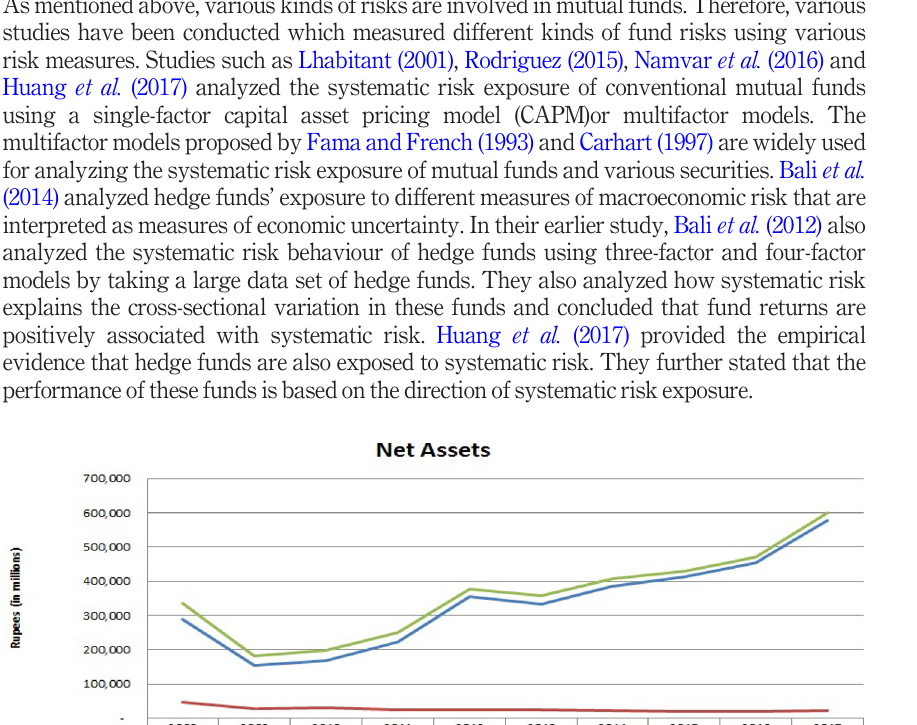
Figure 1. Growth of the